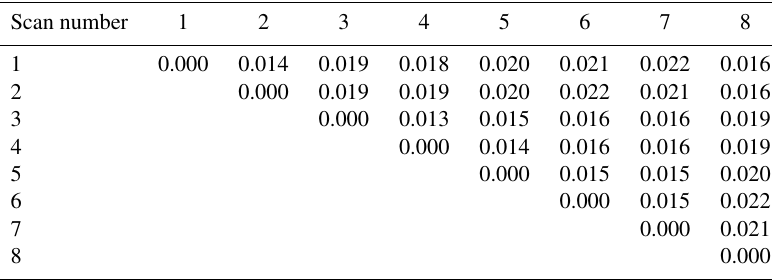
Table 4. Distance between all of the eight scans of the reproducibility test (in